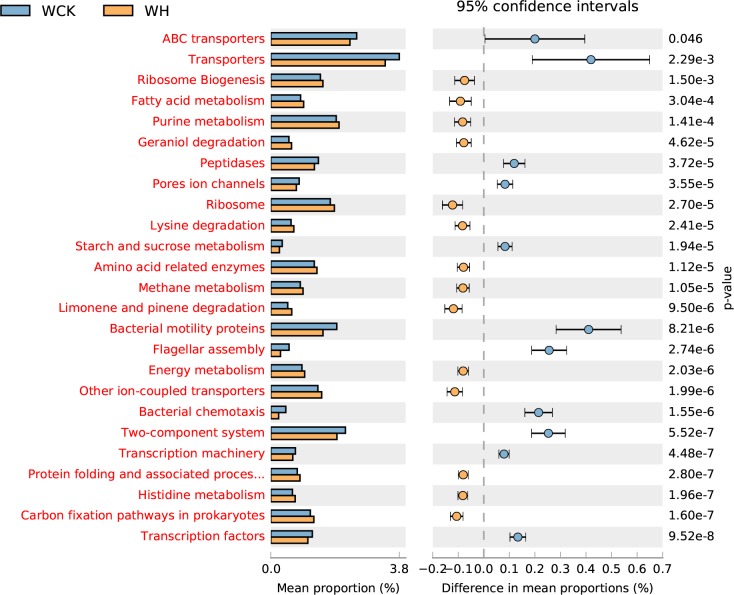
Top-25 functional abundance-difference analysis between the WCK and WH.WH denotes the antibiotic-untreated PWNs receiving the H-level of α-pinene. WCK denotes the antibiotic-untreated PWNs in the control group. The left side of the chart shows the abundance of different functional groups in the two groups of samples. The right side shows the difference in the ratio of the functional abundance in the 95% confidence interval. The functional group shown in red indicates p < 0.05.